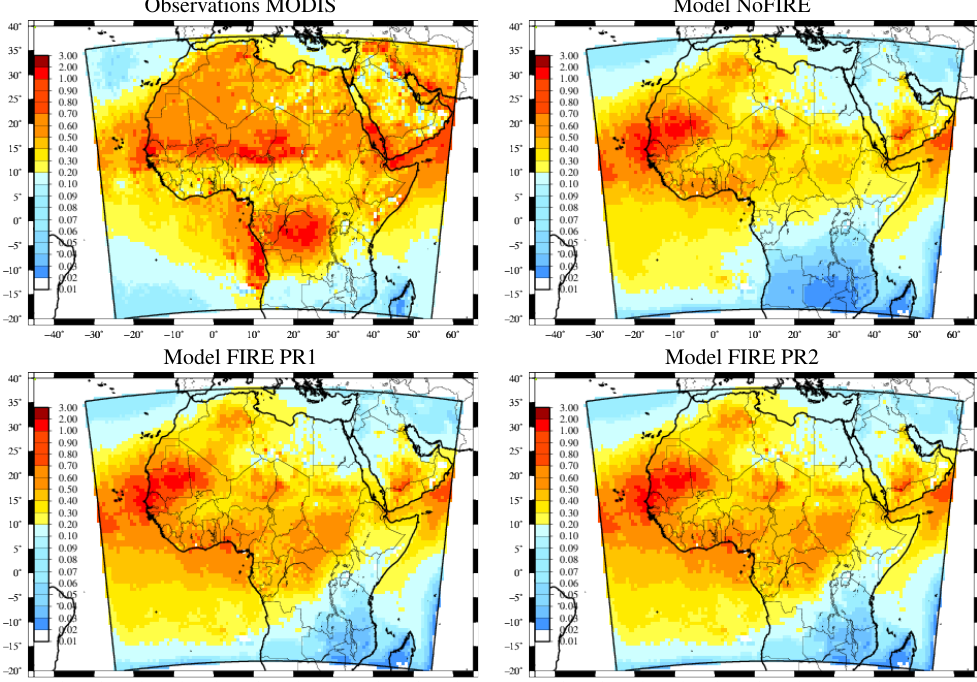
Figure 5. Monthly averaged horizontal distribution of AOD (550nm) for MODIS and CHIMERE simulations NoFIRE, FIRE PR1, and